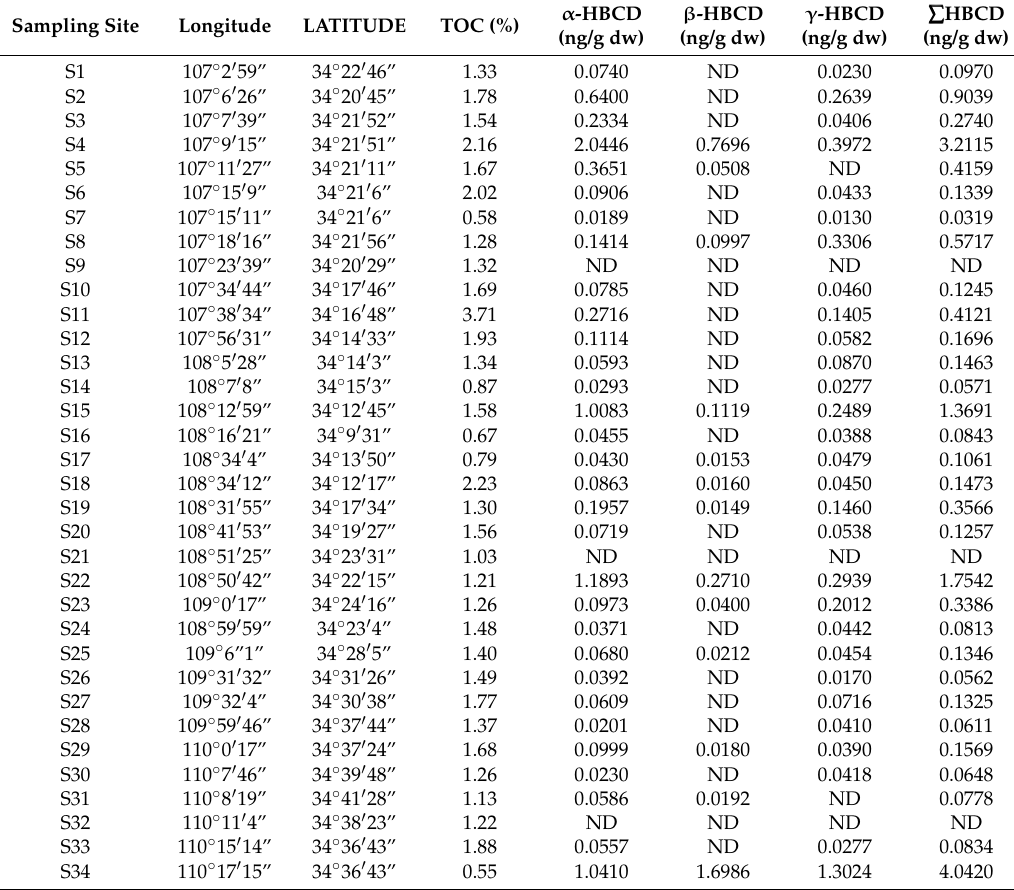
Figure 1. Sampling location of surface sediments in Weihe River basin Shaanxi section, China. Table 1. Information of the sediment samples, total organic carbon (TOC) content and the concentrations of HBCD (ng/g dw).